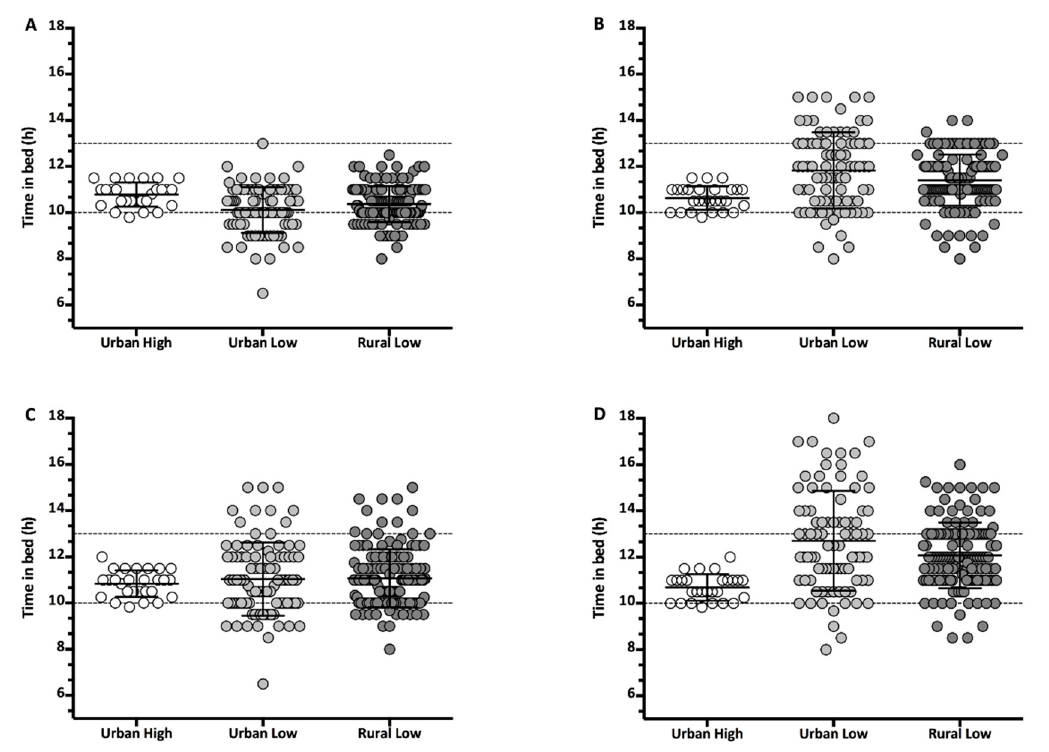
Figure 2. Nocturnal sleep for weekdays ( A ) and weekends ( B ), and total sleep for weekdays ( C ) and weekends ( D ), by setting.